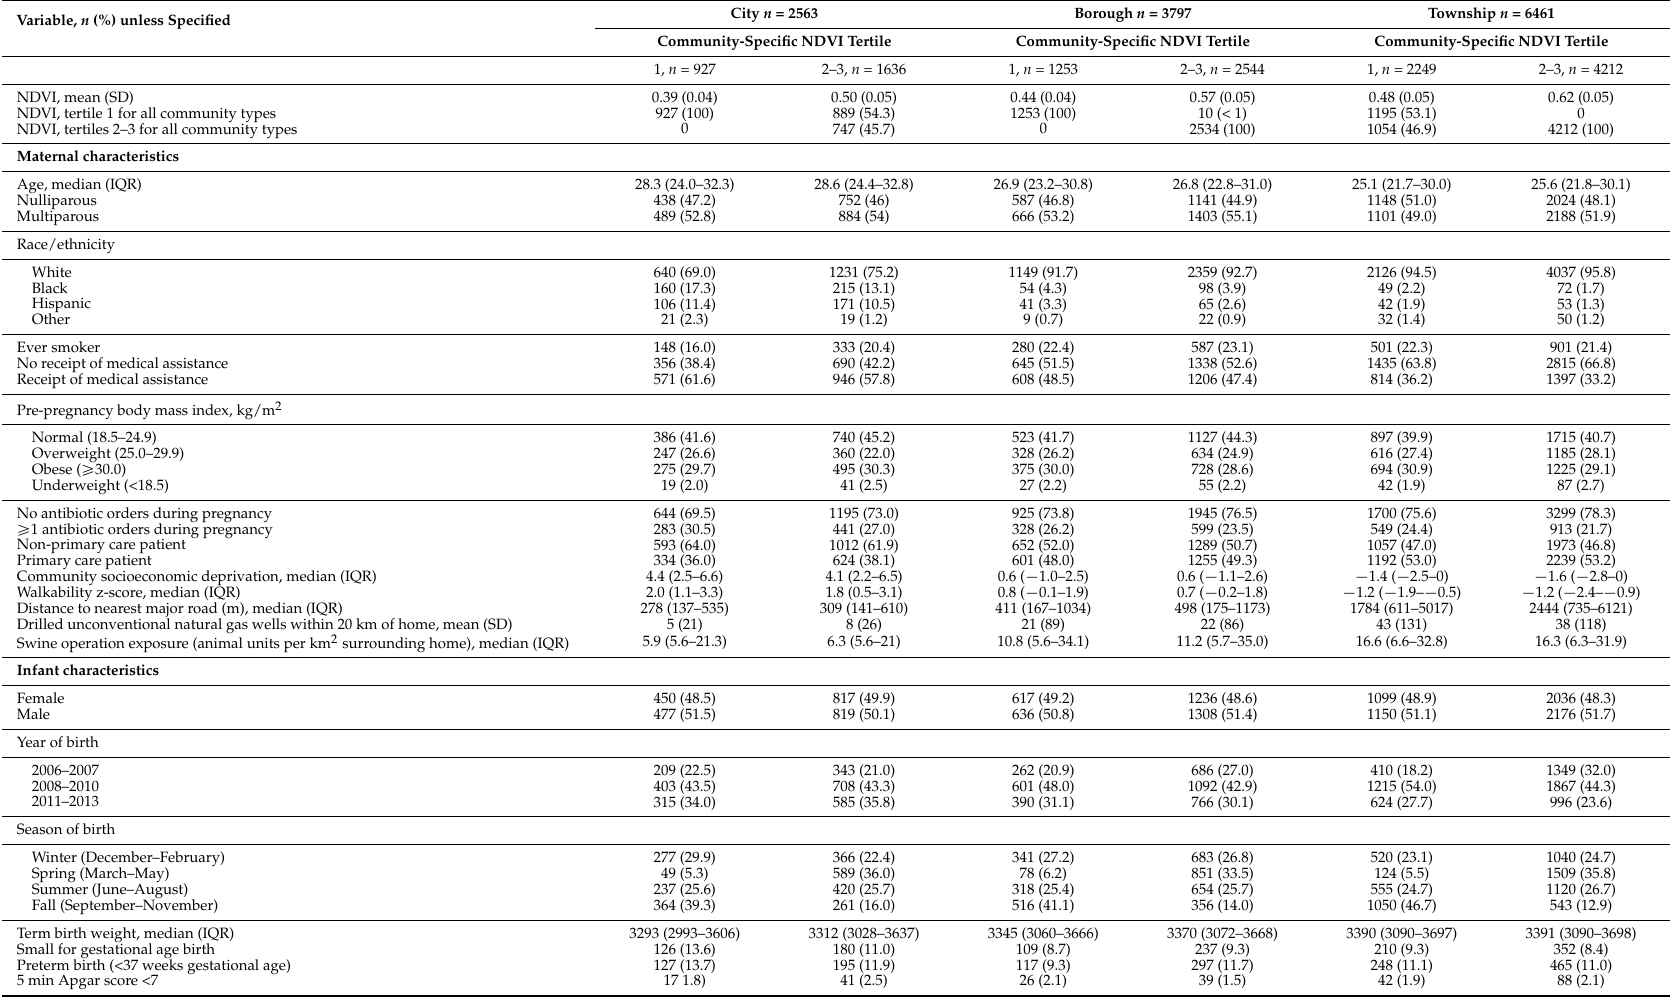
Table 1. Study population demographics restricted sample, n =